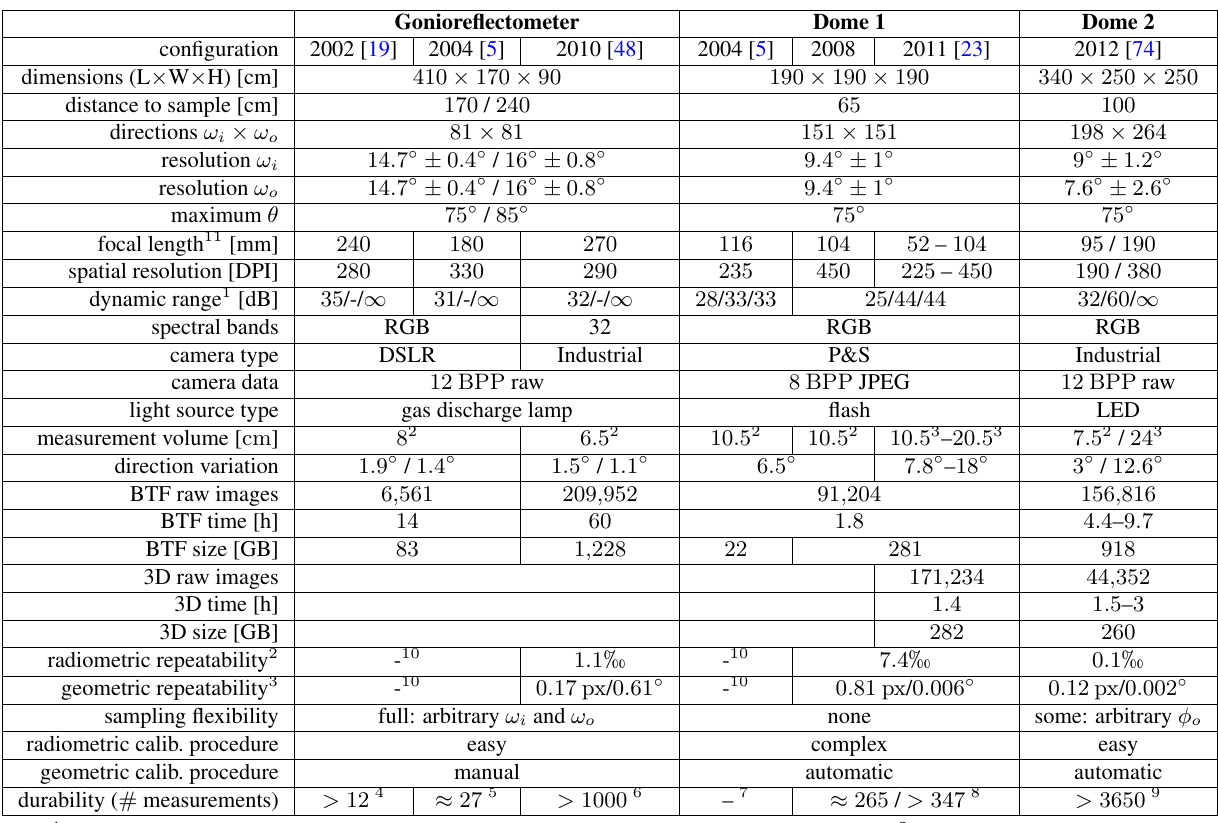
Table 2. Comparison of our setups with respect to the design